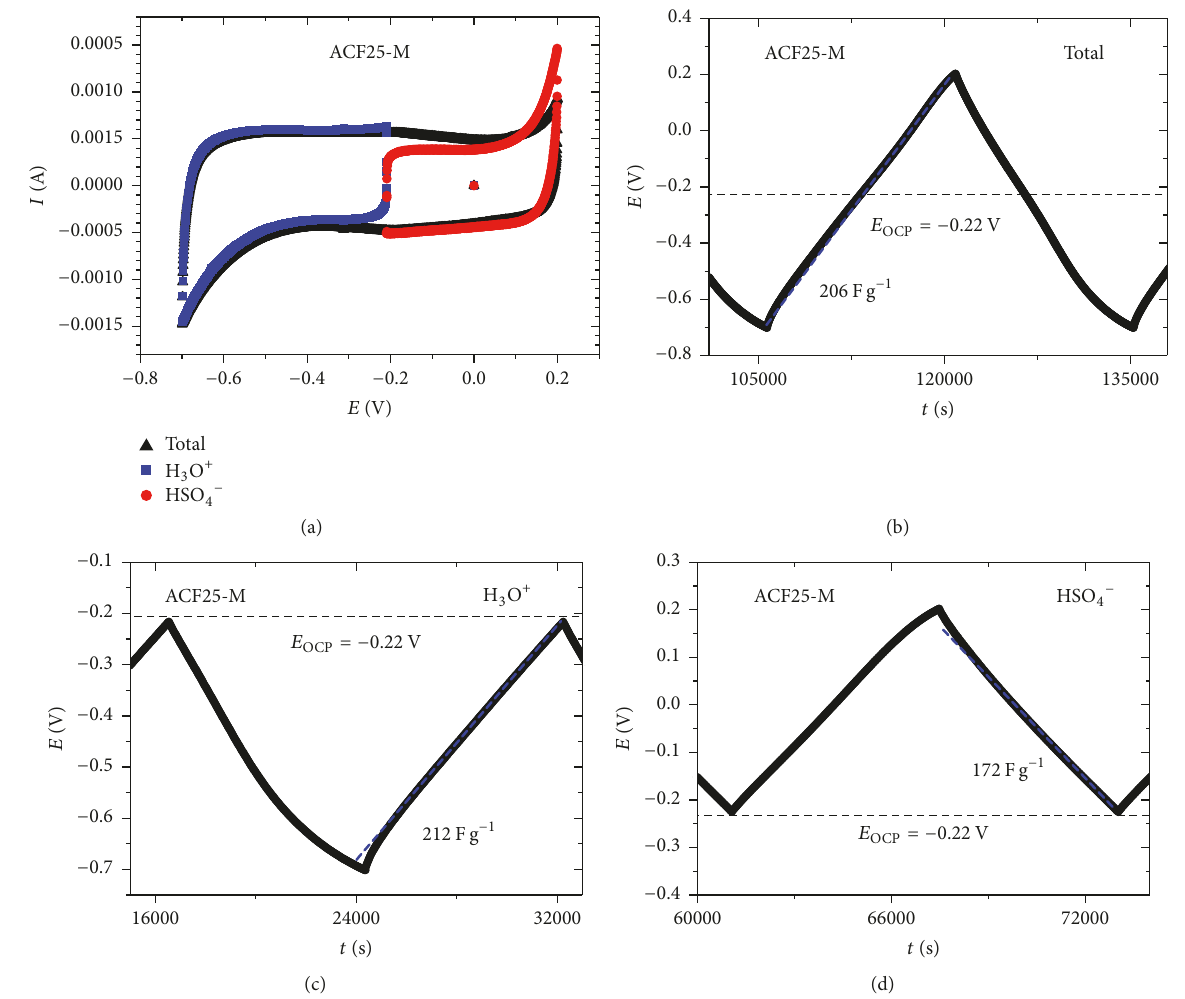
Figure 4: Electrochemical results obtained with three-electrode cells for the monolith ACF25-M: (a) cyclic voltammetry recorded at 0.1mVs −1 in the total voltage range and in the voltage ranges for H 3 O + and HSO 4− ; (b-d) galvanostatic plots obtained at 1mA cm −2 : (b) for both ions in the total voltage range; (c) for the hydronium ion; and (d) for the bisulfate ion.